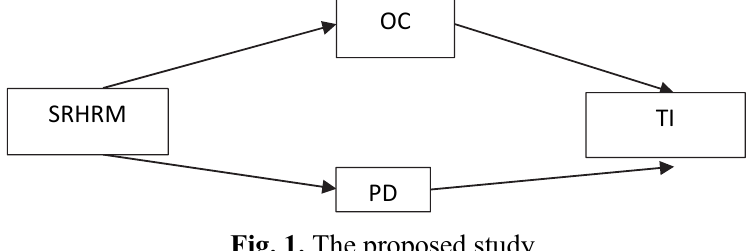
Fig. 1. The proposed